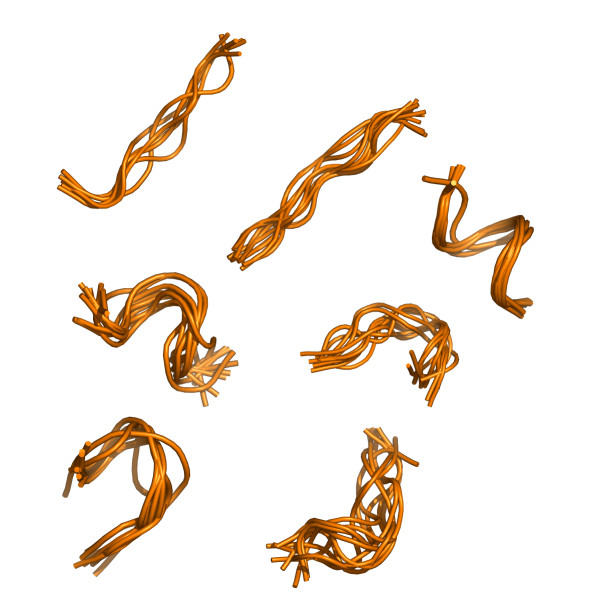
Selected examples of local structure clusters, including local structures like helices, beta strands, and beta strands merging into turns or loop regions. Each cluster is represented by ten randomly chosen fragments (superpositioned by Kearsley's quaternion method [19] and visualized in PyMOL [20]). Some of these clusters represent well defined local patterns, whereas others are only a rough grouping of similar structures.